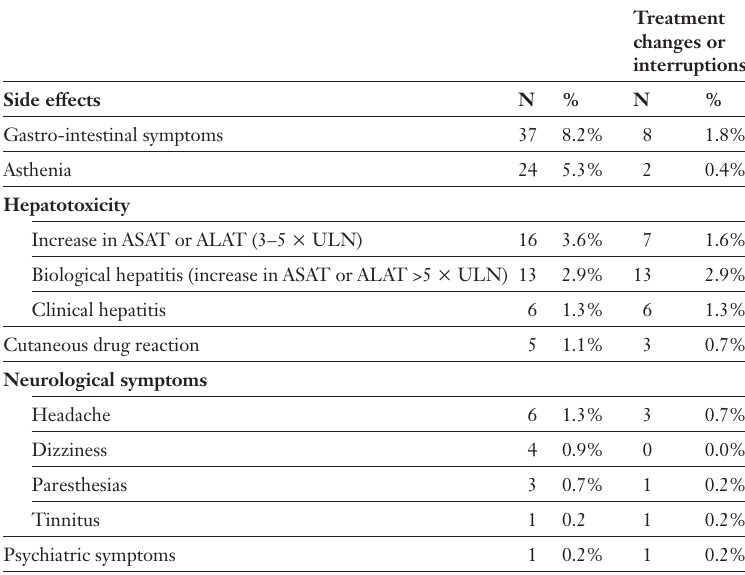
isoniazide-related side effects during treatment for latent tuberculosis infection (lTBi). ASAT: Aspartate amino-transferase; and AlAT: Alanine amino-transferase; UlN: upper limit of normal